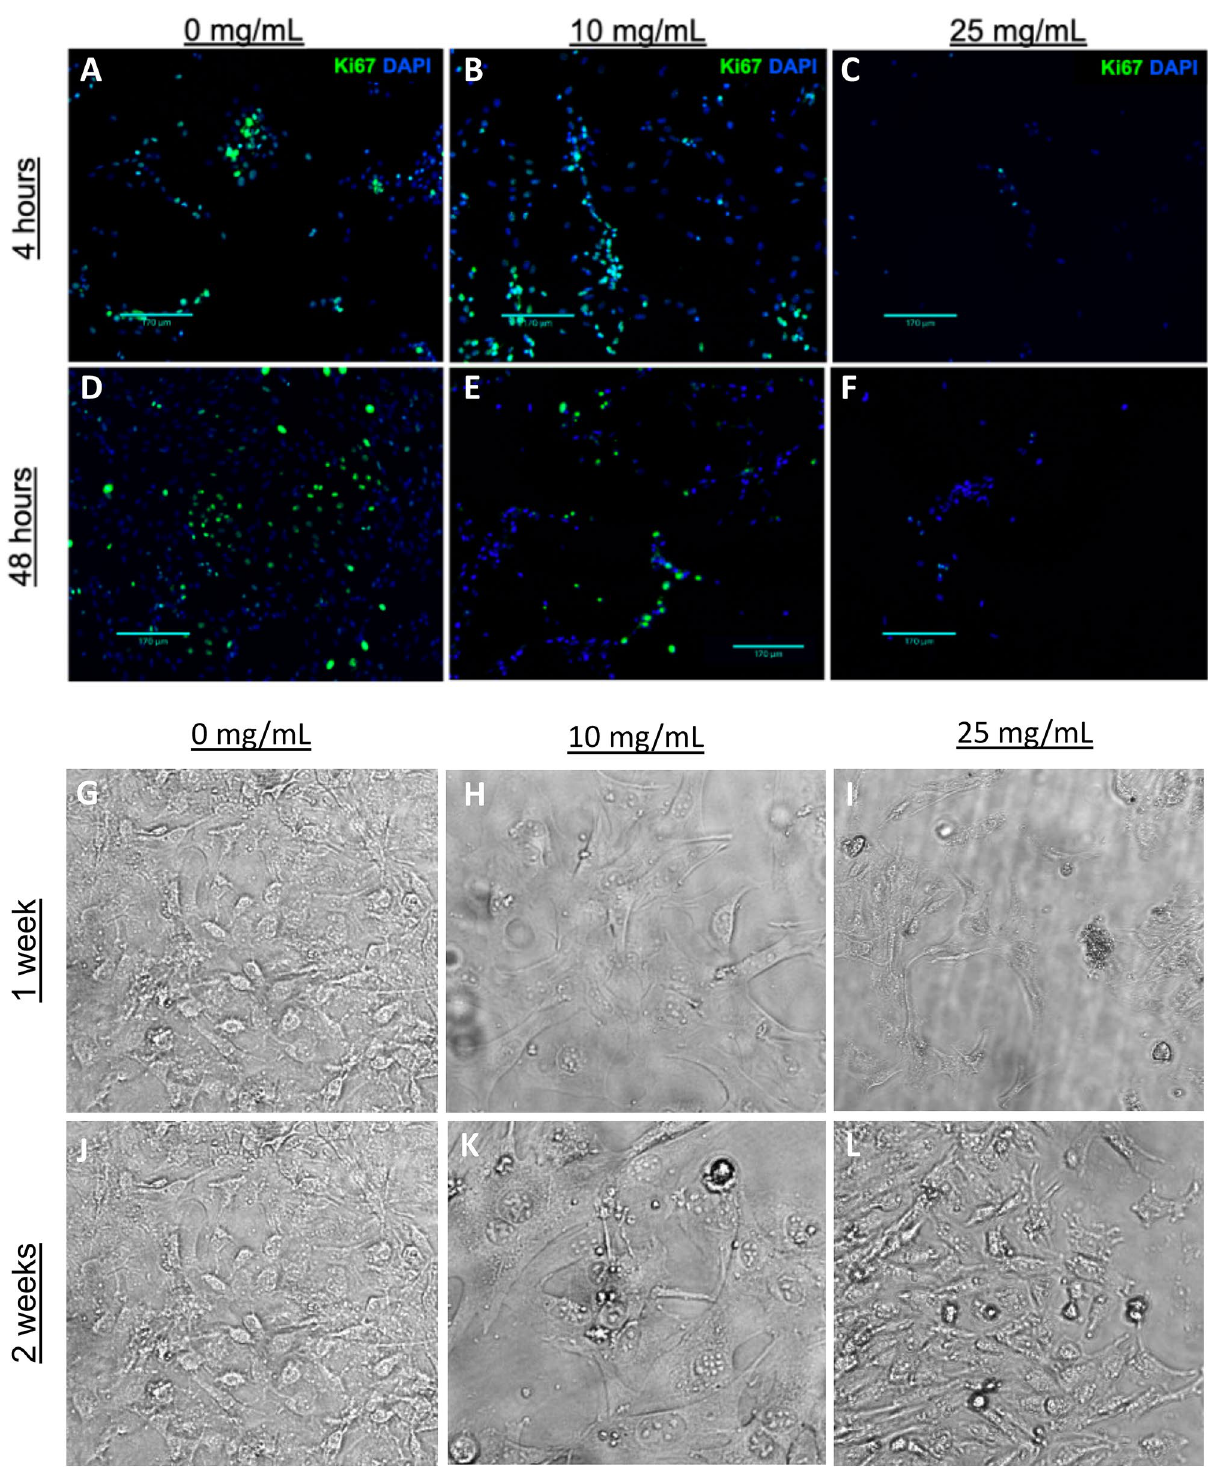
Figure 4. Mineral toxicity to fibroblasts. Ki67 staining denoting fibroblast proliferation following 4 h exposure to 0, 10 and 25 mg/mL of mineral mixtures (containing 95 wt.% smectite with 5 wt.% pyrite and exchanged with 30 mM Fe 2+ SO 4 ) at 4 h post dose (A–C) and 48 h post dose (D–F) . Scale bars = 170 µm. Brightfield imaging (×10 magnification) of long-term recovery of fibroblasts following 4 h exposure to 0, 10 and 25 mg/mL of minerals at 1 week post exposure (G–I) and 2 weeks post mineral exposure (J–L)